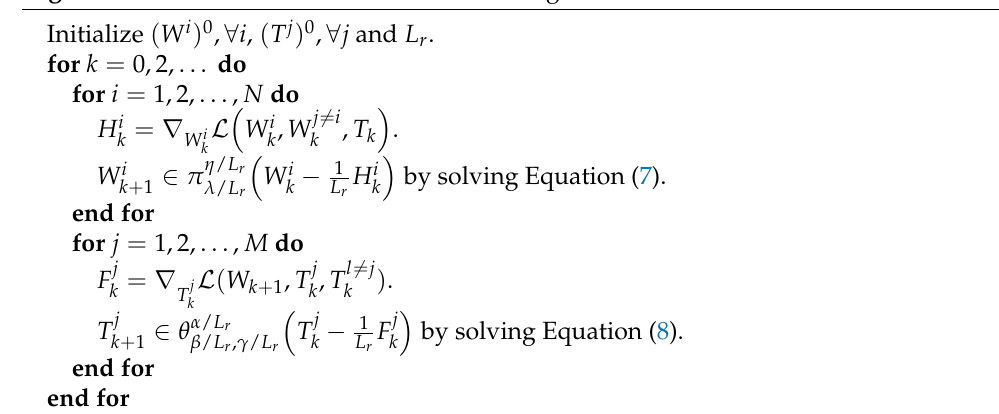
Algorithm 1 The framework of MobilePrune